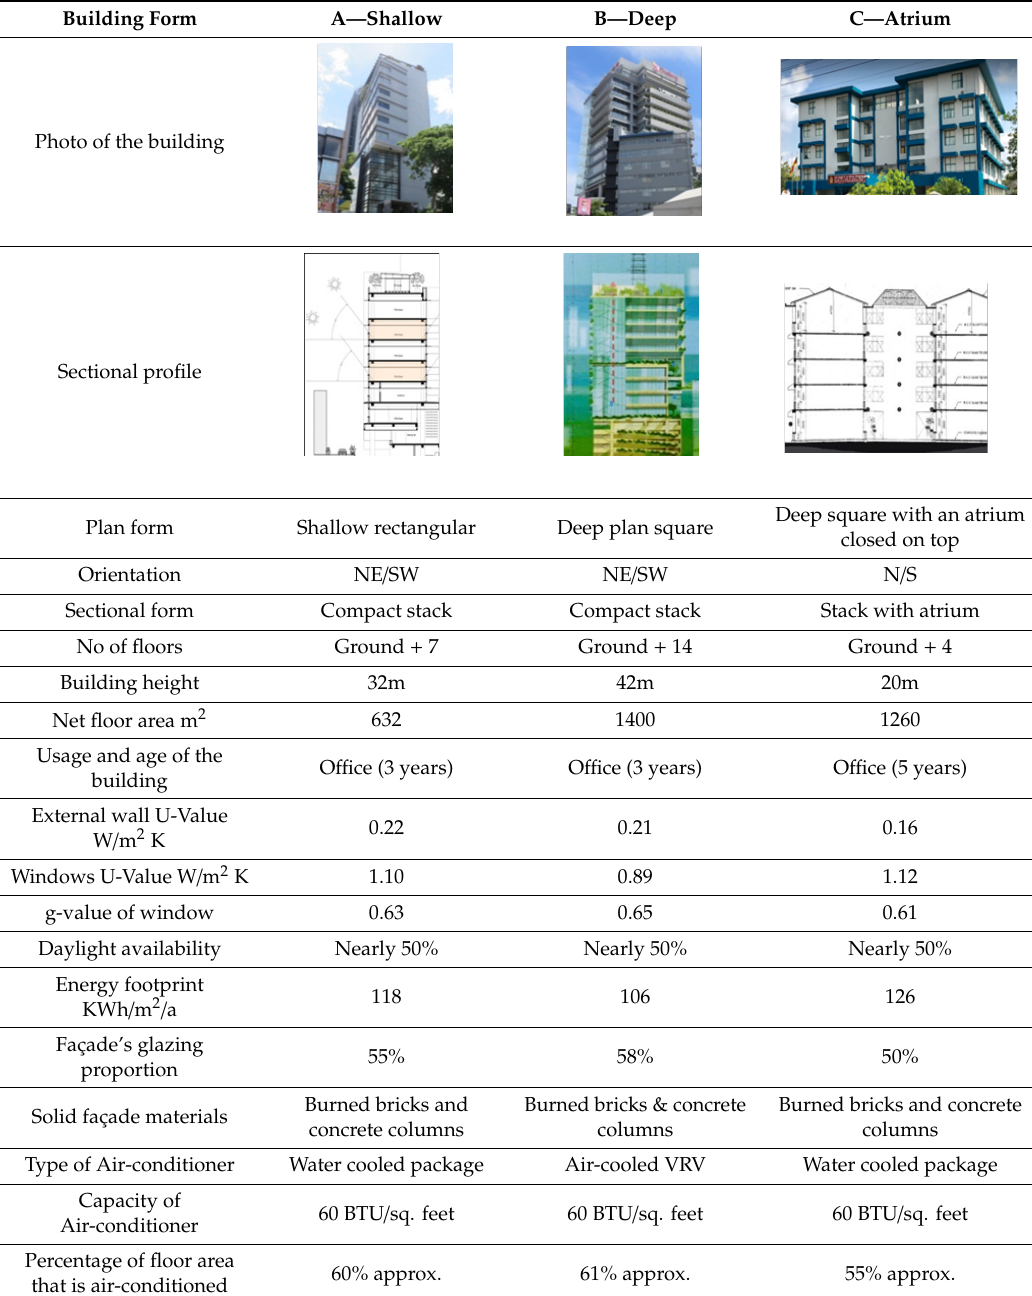
Table 2. Three basic plan form typologies (shallow, deep and covered atrium) selected from a larger population of 86 buildings for the thermal performance